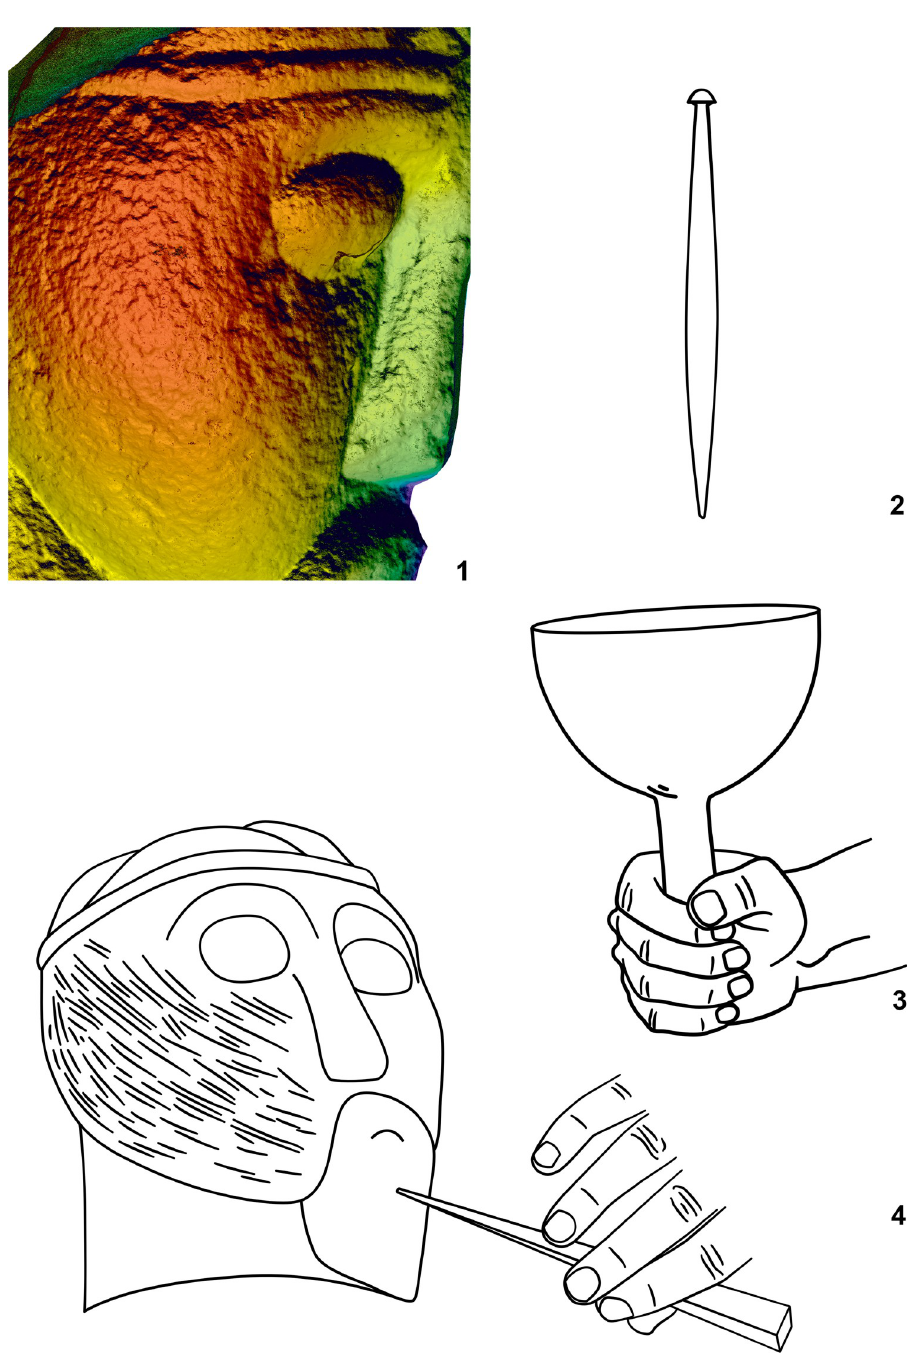
Fig 9. Fragment of the head (statue 3) from Glauberg. 1 the digital model shows individual traces; 2–3 the reconstructed tool and the mallet; 4 reconstruction of the finishing of the surface in parallel rows (author: M. Cihla and F. R.